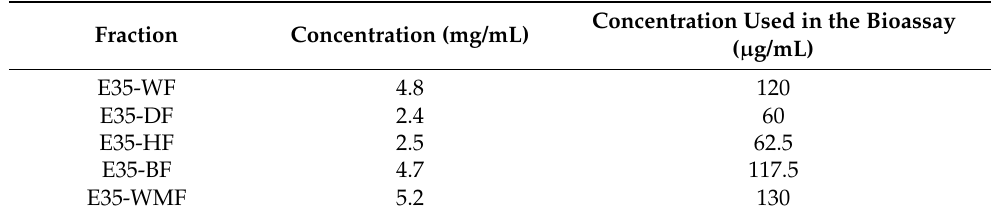
Table 3. Fractions obtained from the crude extract of M. arbuscula